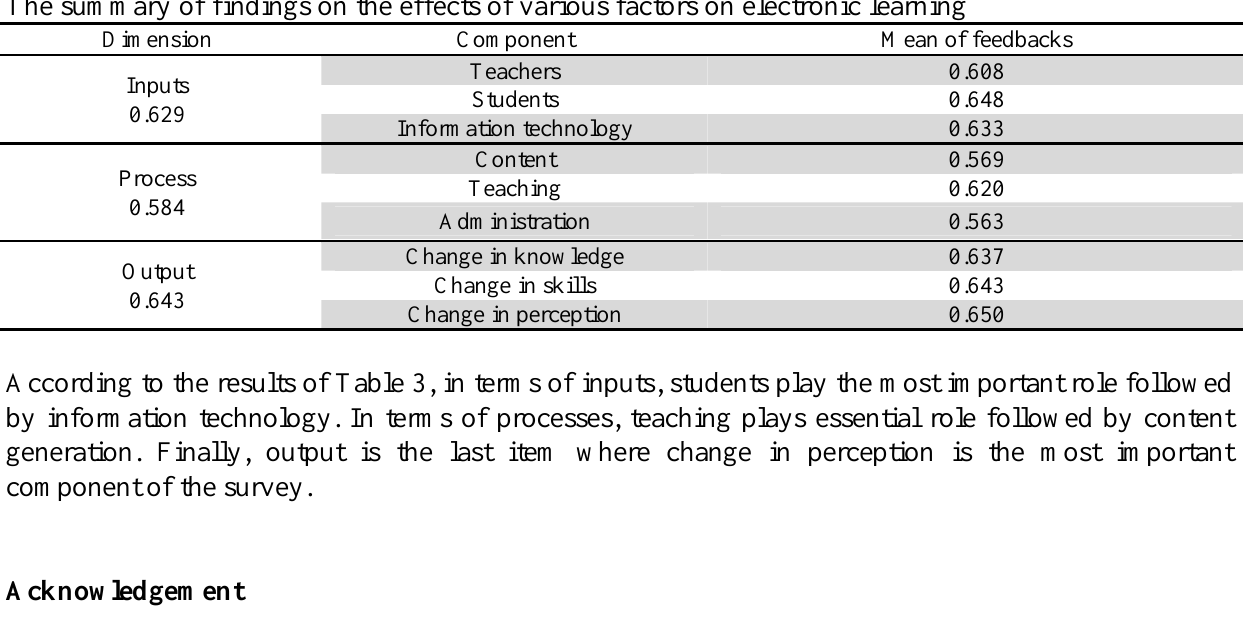
The summary of findings on the effects of various factors on electronic learning